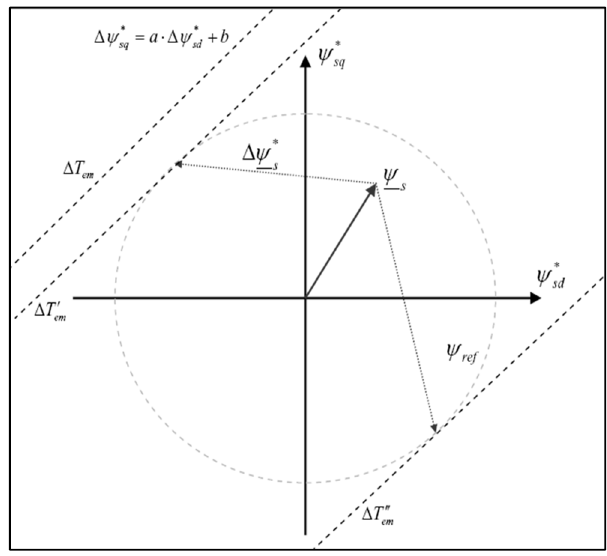
Figure 5. Condition with ∆ T em torque request such that ∆ < 0.